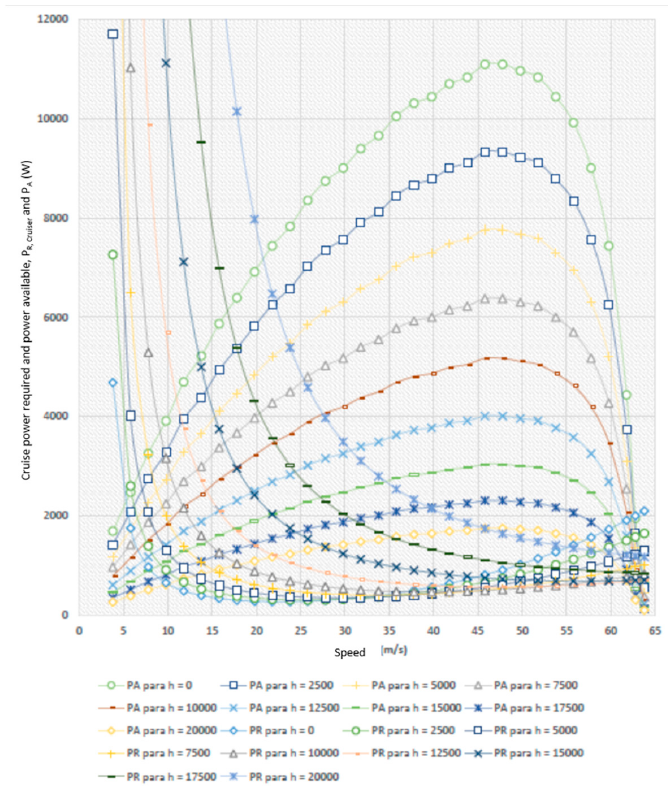
Figure 22. Available power and required power for each flight altitude. Where P A is power available (W) and h is altitude (m).